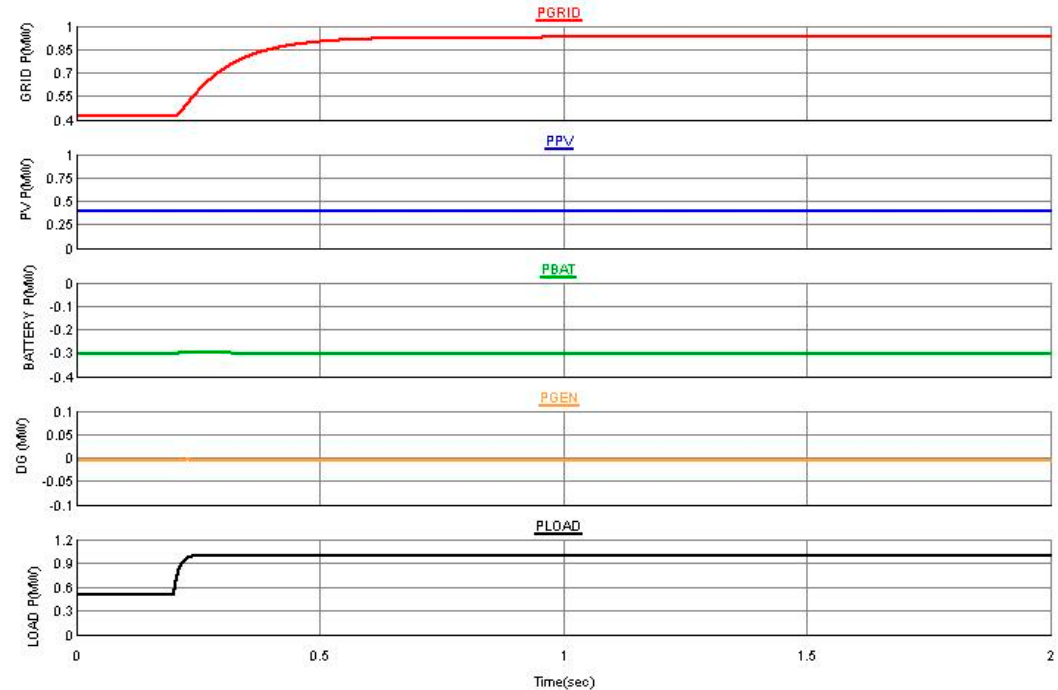
Figure 13. Grid power P GRID , PV array output power P PV , battery power P BAT , generator power P GEN and load power P LOAD.